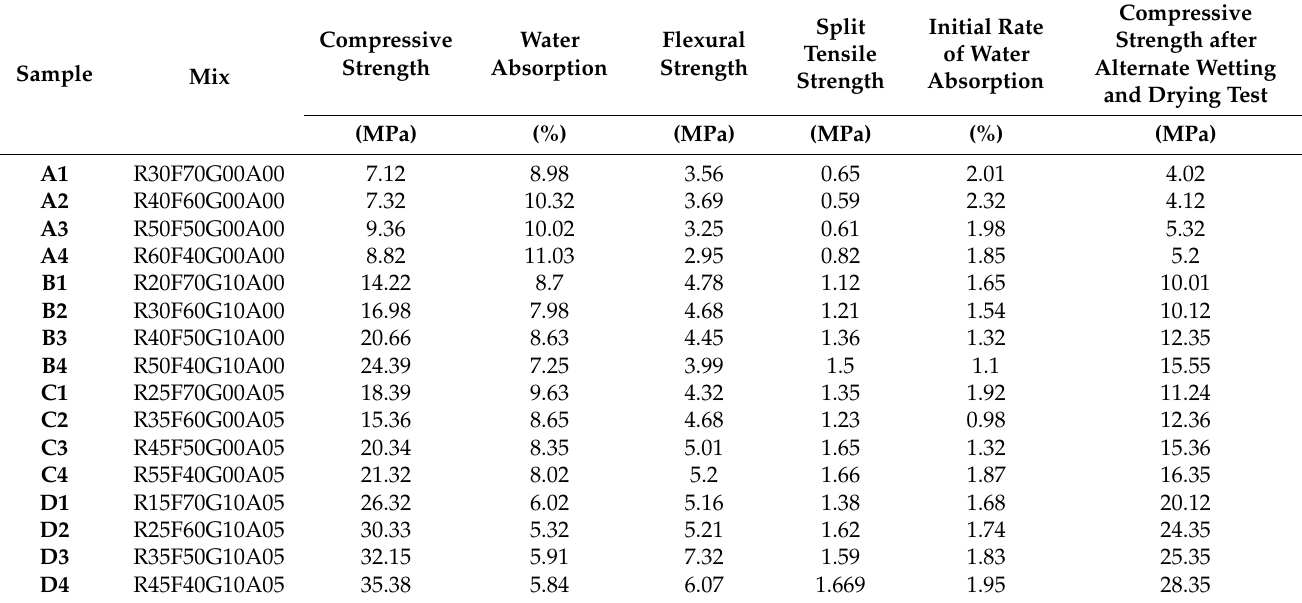
Table 13. Mechanical strength and water absorption of red mud bricks after 28